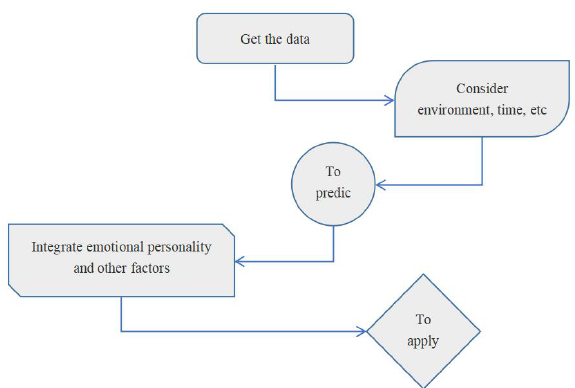
Fig. 1. Upgrading from low-level visual features to